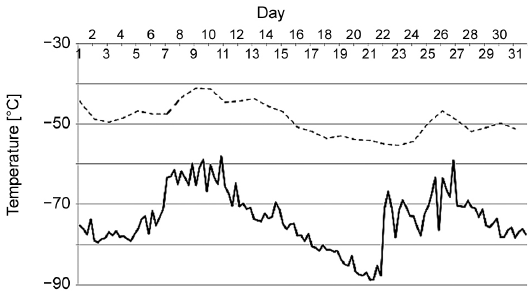
Fig. 11. The Vostok surface (solid line) and 500 hPa (dashed line ~5500 m) temperature records for July 1983 (acc. to Turner et al.